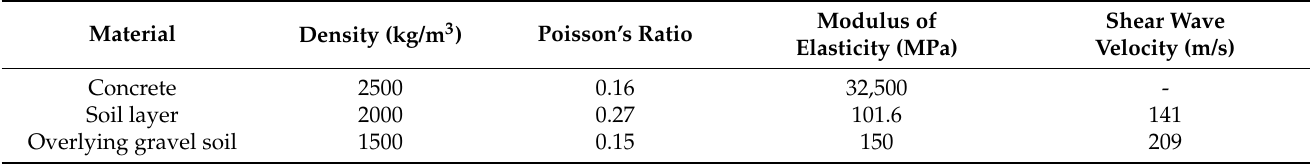
Table 1. The material properties of the model.